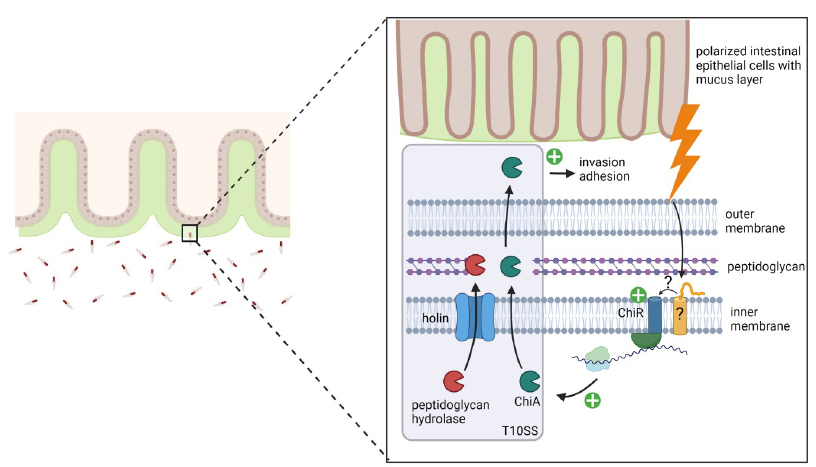
Fig 5. Proposed model for the controlled expression and secretion of virulence factor ChiA in S. Typhimurium. Upon contact with polarized IEC, mucin glycoproteins of the mucus layer induce the expression of the inner membrane-bound transcriptional regulator ChiR. ChiR accumulation subsequently leads to the induction of ChiA expression. Once ChiA is expressed, it is efficiently secreted by a holin/peptidoglycan hydrolase-dependent protein secretion system, also referred to as the Type 10 Secretion System (T10SS). Secreted ChiA then promotes the adherence of S . Typhimurium to intestinal epithelial cells, followed by increased invasion into these host cells. The model was created using